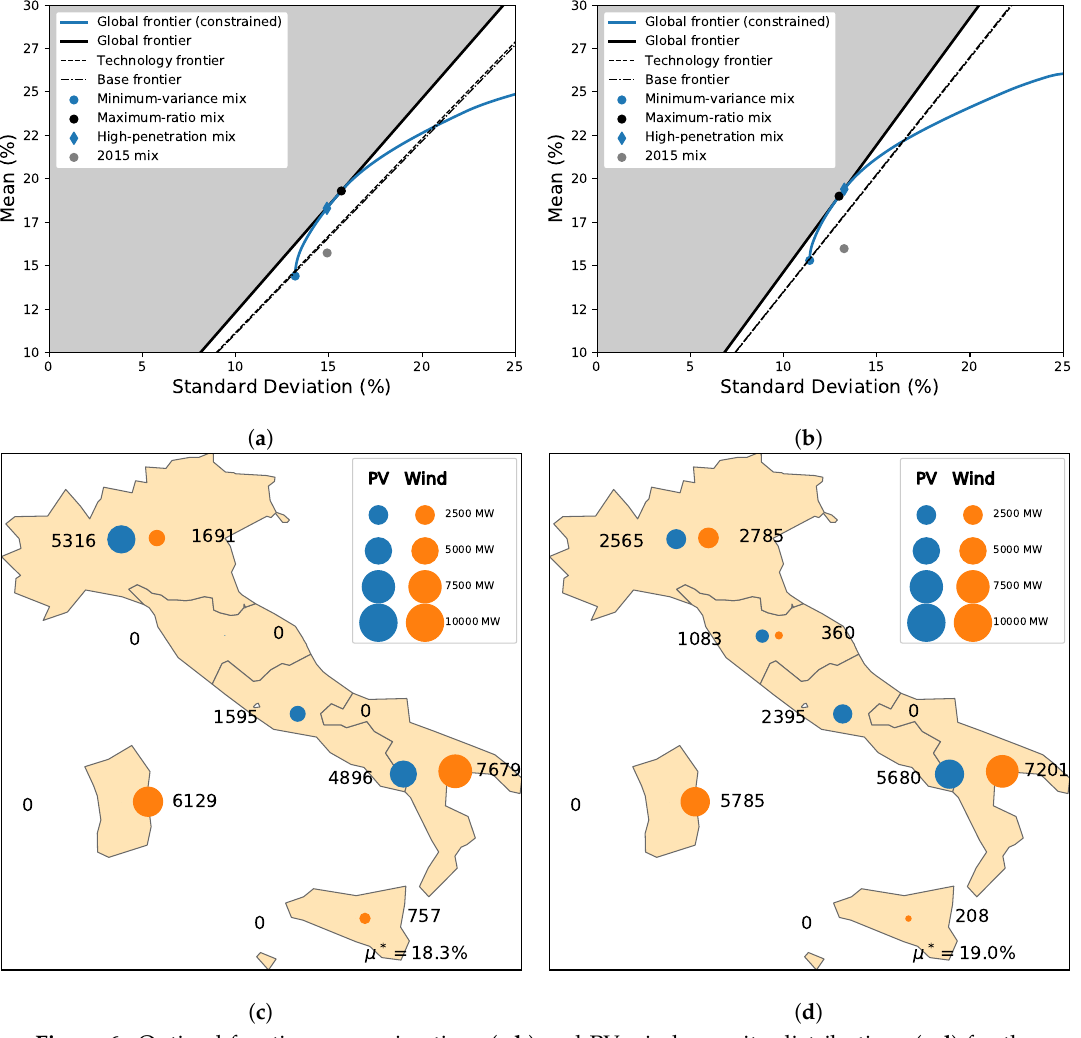
Figure 6. Optimal frontiers approximations ( a , b ) and PV-wind capacity distributions ( c , d ) for the global strategy computed using hourly MERRA-2 data with 10 m-winds ( a , c ) and with 50 m-winds ( b , d ). To be compared with Figures 4a and